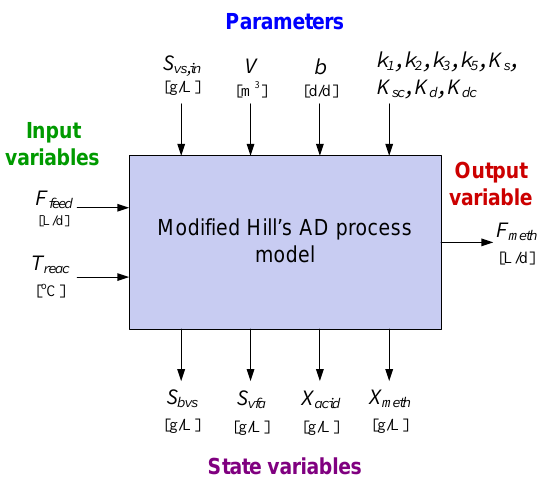
Figure 3: Overall block diagram with variables and pa- rameters of the modified Hill’s model (19)- (28).